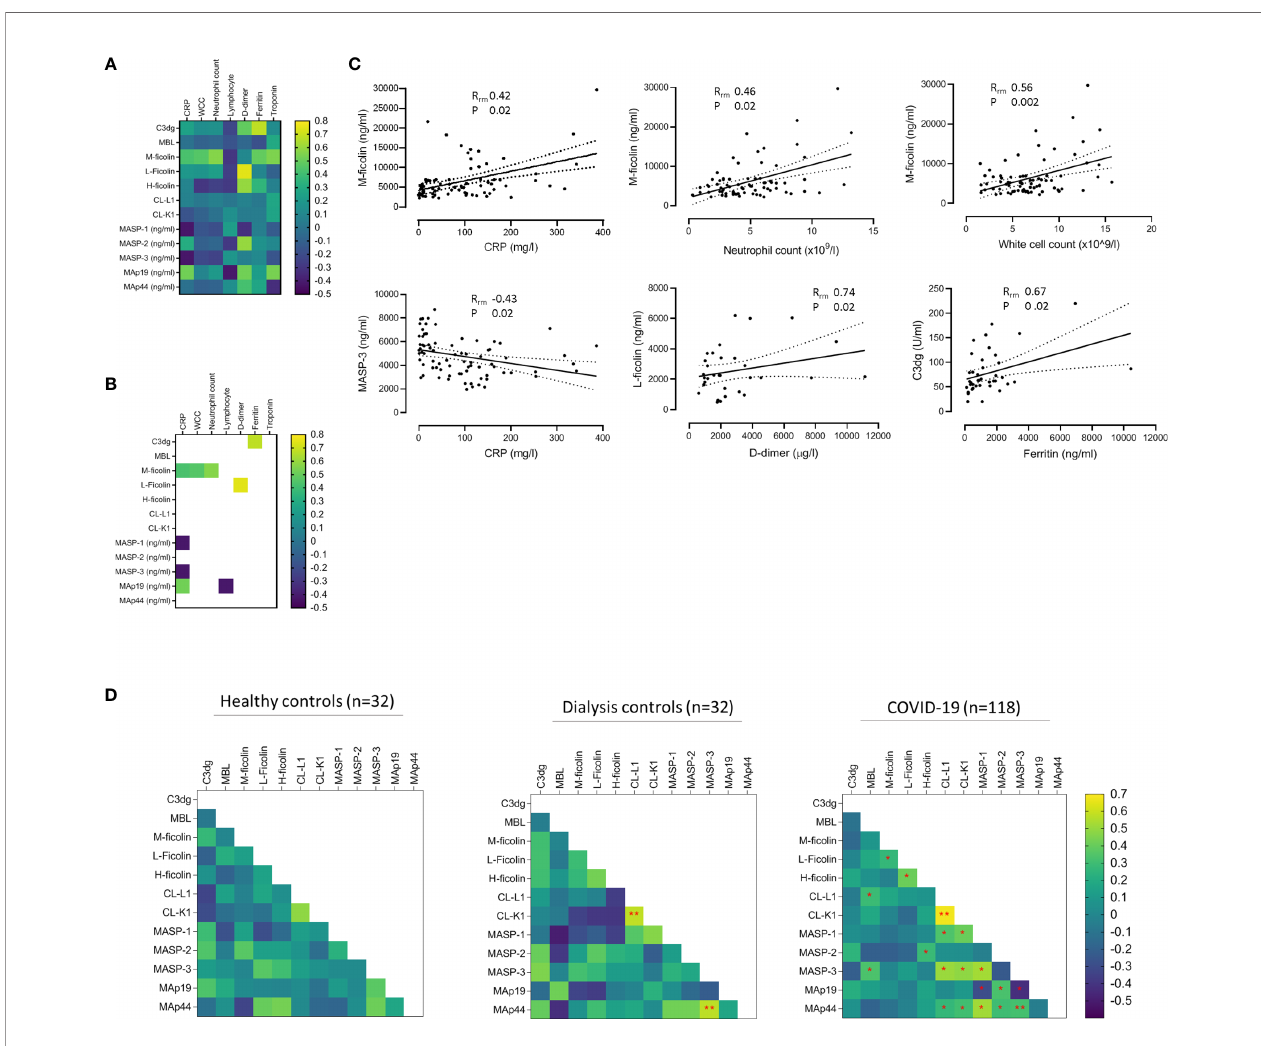
FIGURE 4 | Associations between lectin protein levels and biomarkers of COVID-19 severity. (A) Heat map of correlations between lectin proteins and clinical biomarkers in 33 patients with COVID-19. Correlations calculated from 80 samples pairs for CRP, 79 for white cell count (WCC), 75 for neutrophil count and lymphocyte count, 33 for D-dimer, and 40 for troponin and ferritin. (B) Heat map of correlations that reached statistical signi fi cance after adjusting p-values for multiple analyses. Of these, six correlations had best fi t line gradients that were signi fi cantly non-zero (C) . Solid and dotted lines show the lines of best fi t and 95% con fi dence intervals (95% CI). (D) Heat map of correlations between lectin protein levels in 32 healthy controls, 32 haemodialysis patients without COVID-19 (dialysis controls) and 118 samples from 33 patients with kidney impairment and COVID-19. Red stars mark correlations that reached statistical signi fi cance after adjusting for multiple analyses. Double red stars mark statistically signi fi cant correlations detected in more than one cohort. For the healthy controls and dialysis controls cohorts, we calculated Pearson correlations (R) on log-transformed data. For the COVID-19 cohort, we applied linear mixed models and repeated measures correlation technique (rmcorr) of log-transformed data to calculate correlations (R rm )